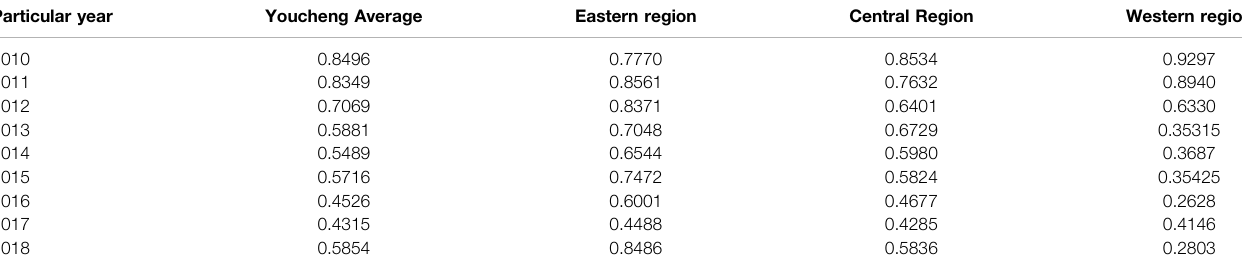
TABLE 4 | Static ef fi ciency evaluation results of green growth of oil and gas resource-based cities in different regions. Particular year